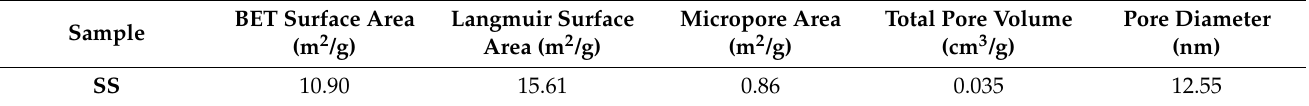
Table 4. Steel slag (SS) BET surface area characteristics.